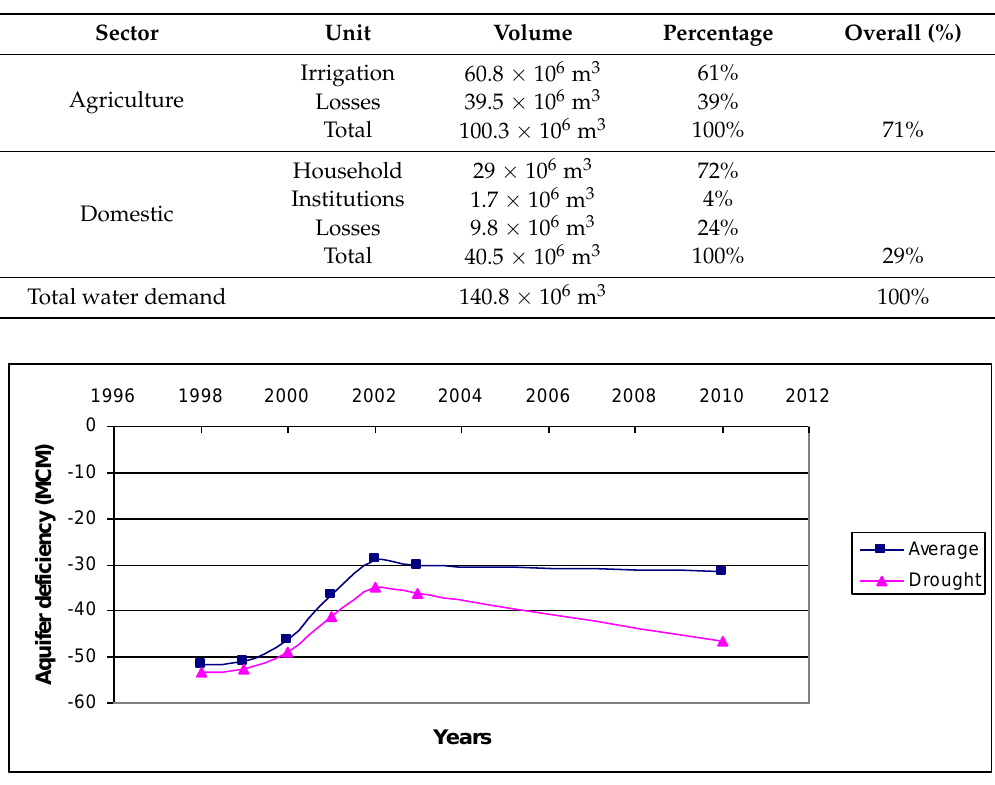
Figure 5. Estimated aquifer deficiencies under normal (average) and drought weather conditions owing to excessive water extraction in Northern Cyprus (NC) between 1998 and 2010 [27,28].